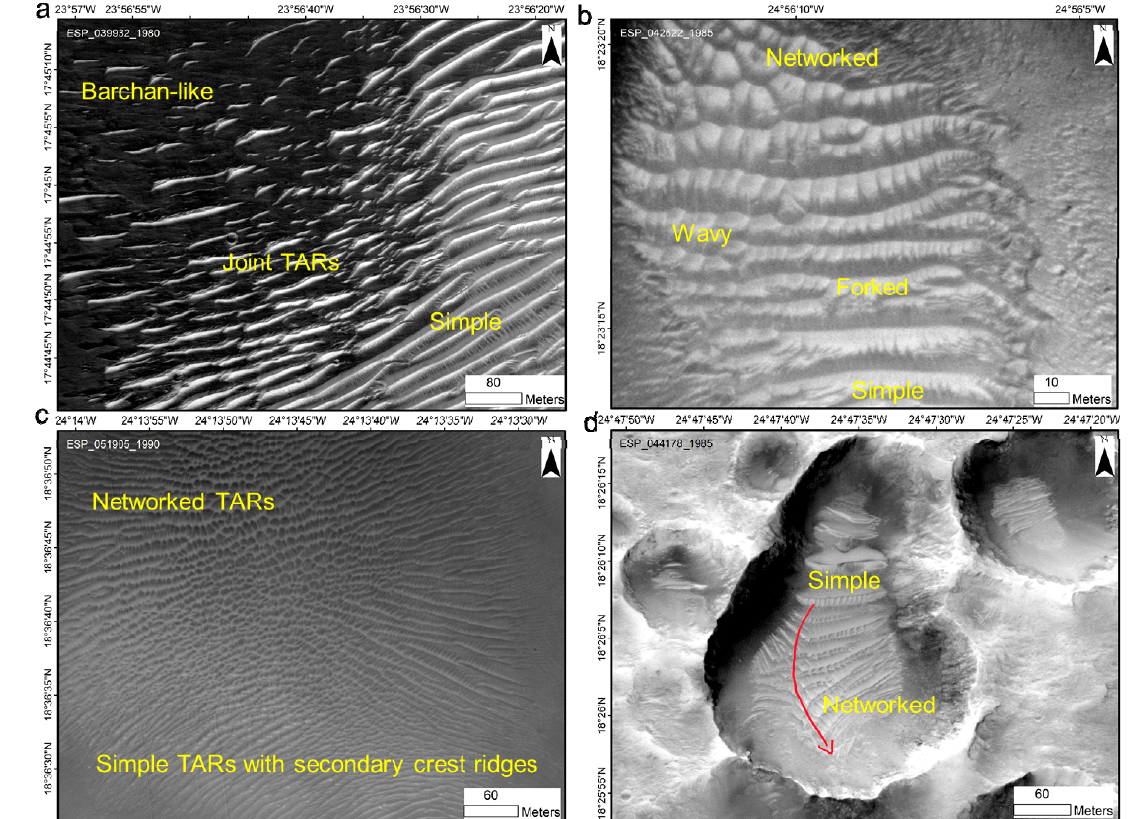
Figure 7. Examples of TAR transitions: ( a ) barchan-like TARs coalescing and forming simple TARs, ( b ) transition from simple to forked to wavy with associated smaller secondary ripples, and finally to networked TARs, ( c ) simple TARs with secondary crest ridges transitioning to networked TARs, and ( d ) downslope transitions from simple to networked along the red arrow possibly due to the combination of downslope winds and steep topography. HiRISE image credit: NASA/JPL/University of Arizona.